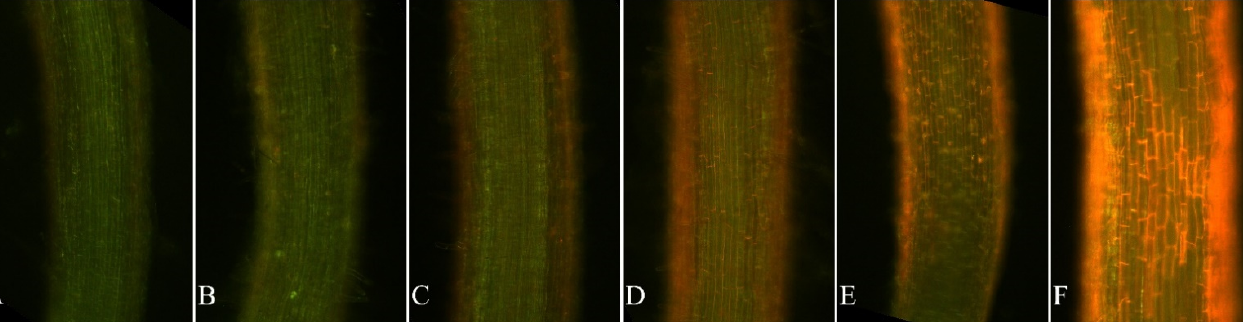
Figure 6. ROS production in lettuce roots after treatments with acacetin. Lettuce seedlings were treated with acacetin at concentrations of ( A ) 0, ( B ) 1, ( C ) 10, ( D ) 50, ( E ) 100 and ( F ) 500 μ M for 48 h. Roots were stained with DHE. Bright fluorescence shows ROS production (presumably O 2 − ). Bar = 200 μ m.